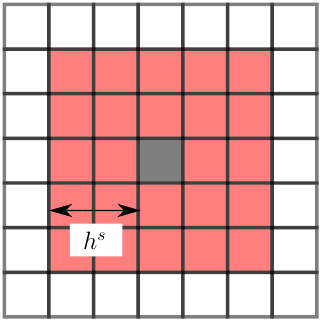
Figure 3. Illustration of the non-causal neighbour- hood of a neighbourhood radius of h s = 2 pixels. The black pixel represents the central pixel and the red pixels represent non-causal neighbourhood. When ex- tracting the neighbourhood, the central black pixel is represented as a random binary value.